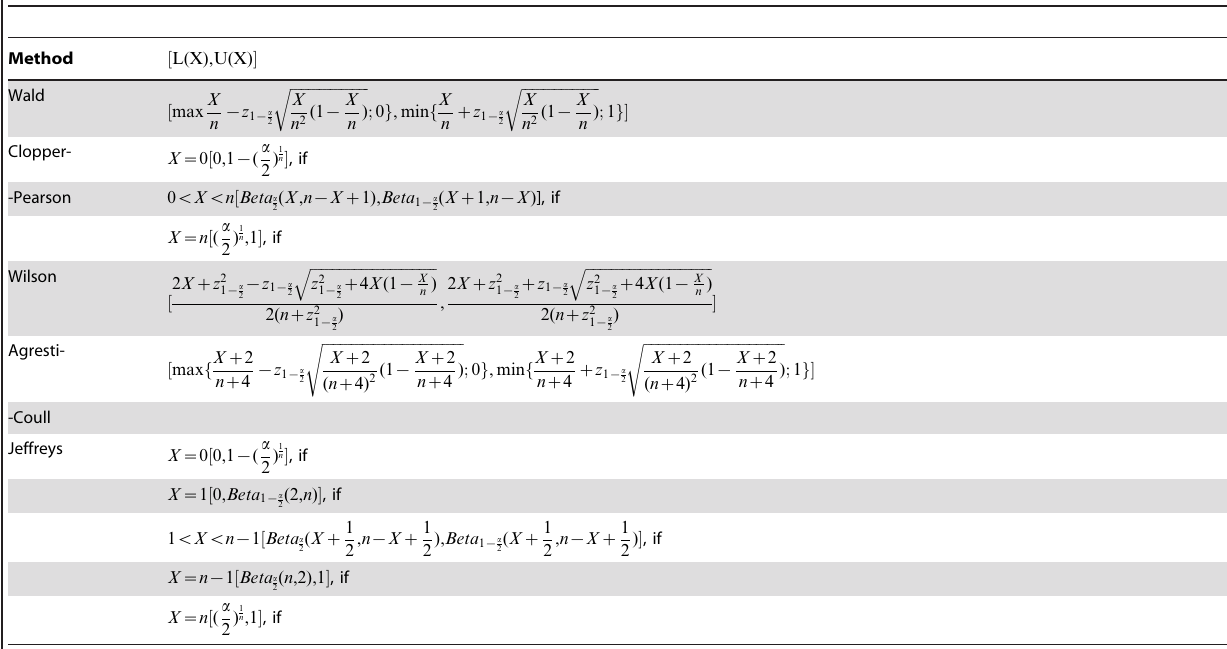
Table 2. Lower – L ( X ) – and upper – U ( X ) – bounds of a 100 | (1 { a )% confidence level for a two-sided confidence interval – X , where X is the number of successes) using different ½ L ( X ), U ( X ) (cid:2) – for a proportion p ( ^ pp ~ n